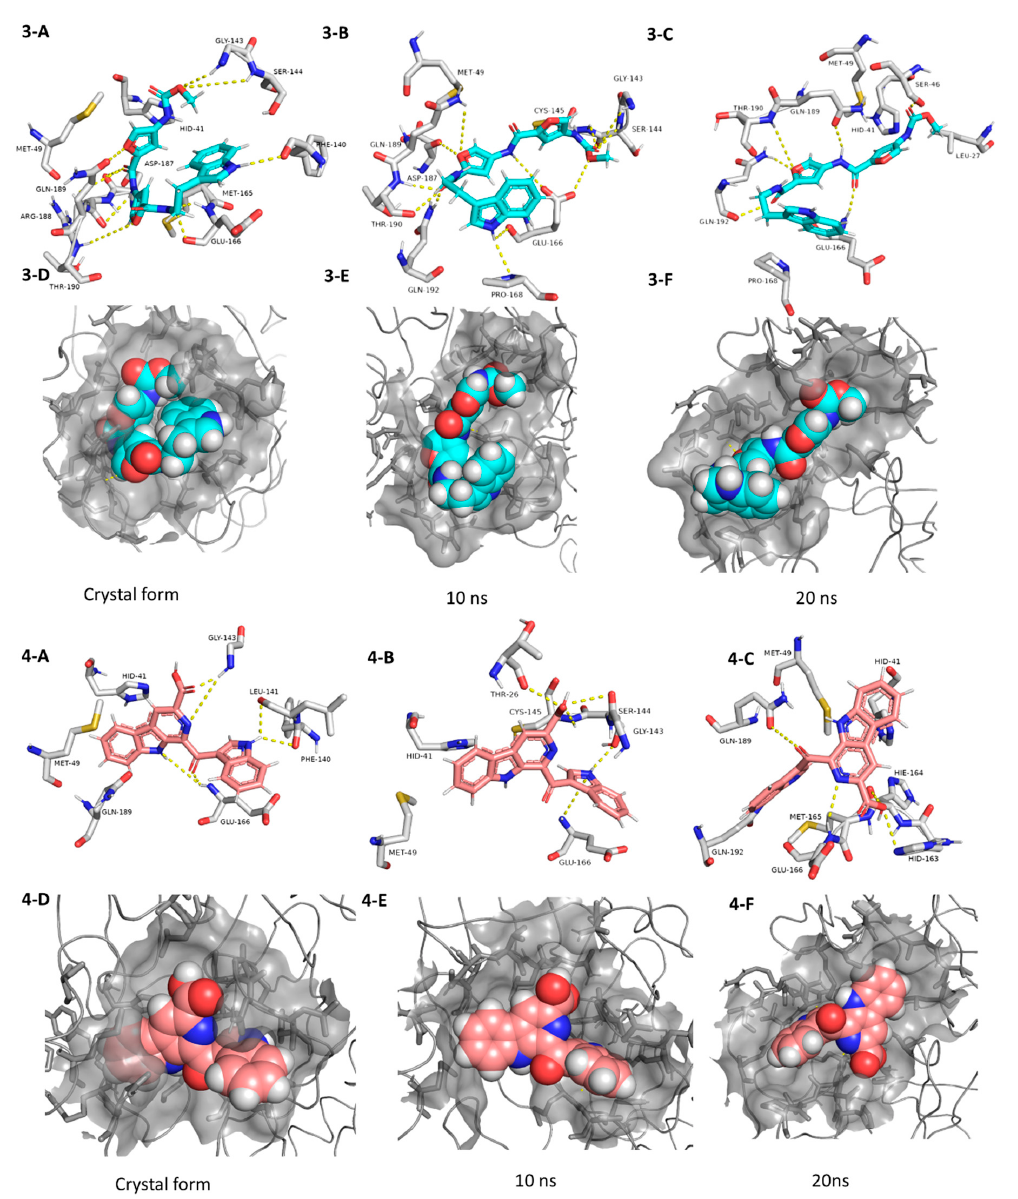
Figure 6. Interactions and binding modes of compounds 3 and 4 (Blue and red molecules, respectively) inside the M pro active site in the crystal form and during MDS ( 3-A – 4-F ). Coming to our next hit, (+)-anthrabenzoxocinone ( 5 ), it showed an interaction pattern similar to the previous candidates ( 1 – 4 , and 7 , 8 ) inside the crystallized form of the enzyme active site. However, from the beginning of the MDS, this compound gradually detached itself from the binding site, and starting from 7.2 ns, it took a different orientation with better interactions (Figure 7 and Table 1). At the end of the MDS, (+)-anthrabenzoxocinone ( 5 ) was able to form a wide network of H- bonds (10 H-bonds) and hydrophobic interactions (4 hydrophobic interactions) (Figure 7). Anthrabenzoxocinone ( 5 ) was isolated from a soil-derived Streptomyces sp. in 2014 [43]. Finally, penimethavone A ( 6 ), which has a flavone structure similar to the co-crystalized ligand (baicalein, 7 ), was able to form molecular interactions almost identical to those of the co-crystalized